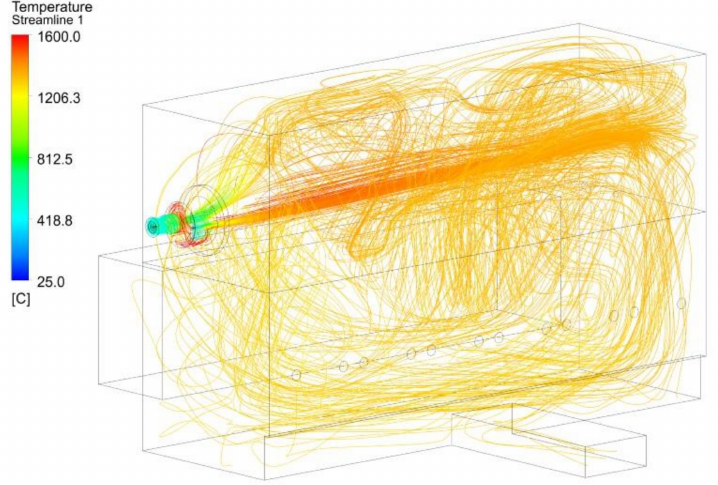
Figure 29. Temperature streamlines for the NG1